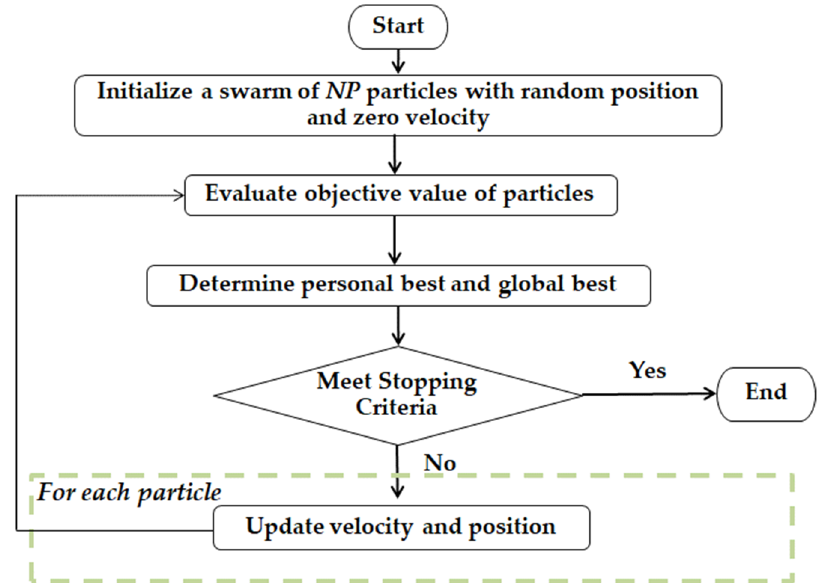
Figure 1. Evolutionary procedure of the particle swarm optimization (PSO) algorithm.